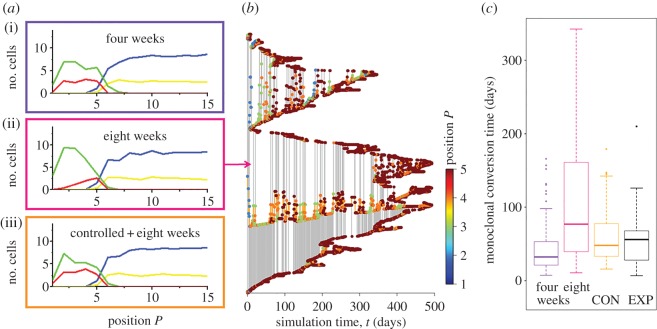
PC distribution affects monoclonal conversion. (a) Simulated long-term cell distributions for an intrinsically defined average PC lifespan of four (i) and eight weeks (ii). A long lifespan enables the PCs to accumulate at the bottom of the crypt leading to a depletion of SCs at this region. Additional extrinsic, cell contact-dependent control of PC lifespan can ensure that the cells intermingle also for intrinsically defined PC lifespan of eight weeks (iii). (b) Typical phylogenetic tree for an intrinsically defined PC lifespan of eight weeks. (c) Box plot of simulated monoclonal conversion times for an intrinsically defined PC lifespan of four and eight weeks and contact-dependent control of PC lifespan (CON). The contact-dependent control leads to monoclonal conversion times that agree with experimental observations. For a direct comparison, pseudo conversion times (EXP) have been generated that fit experimental results by Snippert et al. [2]. More details are given in electronic supplementary material, appendix S4.